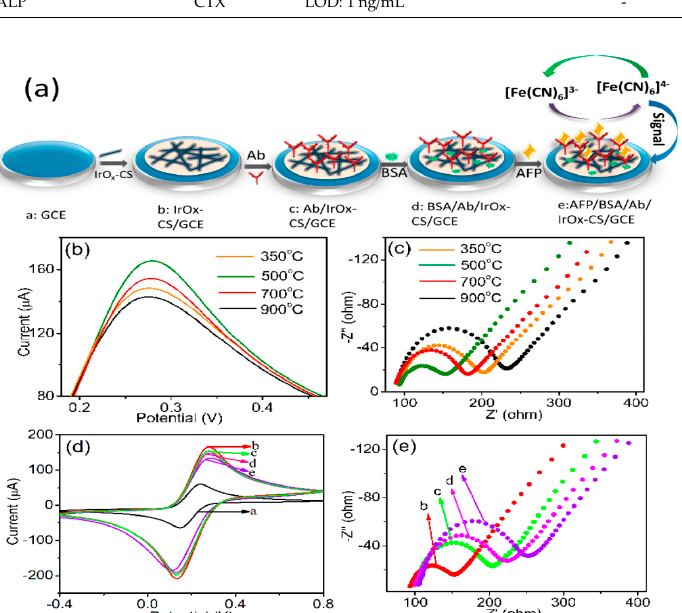
Figure 8. ( a ) A schematic diagram of the detailed preparation process of an IrOx-nanofiber-modified immunosensor. ( b ) cyclic voltammetry curve (CV) and ( c ) EIS spectra of different IrOx-nanofiber- modified immunosensors. ( d ) CV and ( e ) EIS spectra of the fabrication progress of IrOx-nanofiber- modified (annealed at 500 ◦ C) immunosensor in pH 7.4 PBS solution containing 5.0 mM [Fe(CN) 6 ] 3 − / 4 − , where the letters labeling the spectra correspond to the diagram labels in panel a. Reproduced with permission from